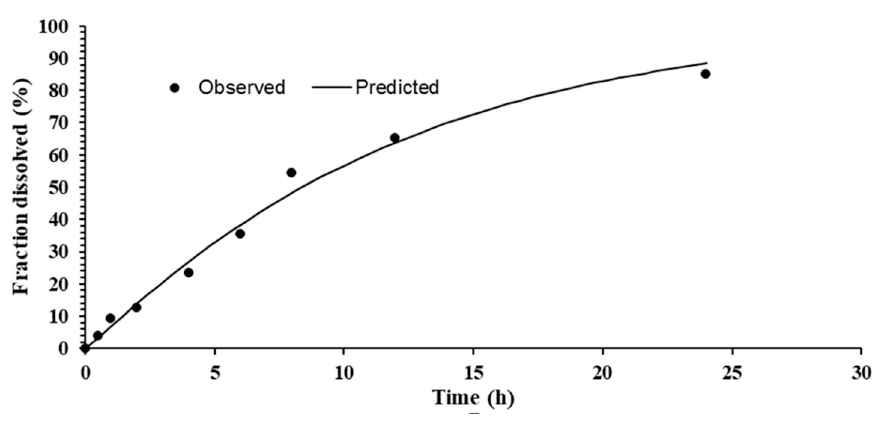
Figure 5. Weibull kinetics model of Capsaicin loaded Nano ‐ crystals.